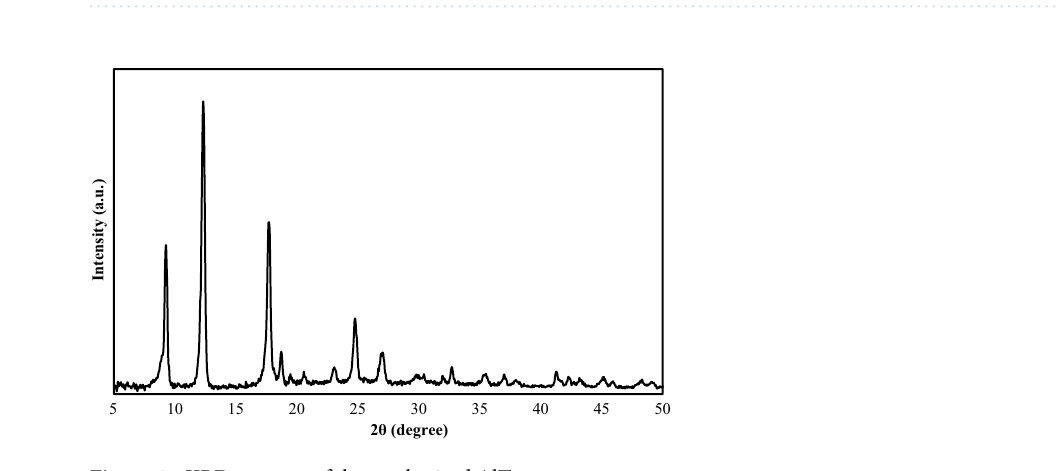
Figure 4. XRD patterns of the synthesized